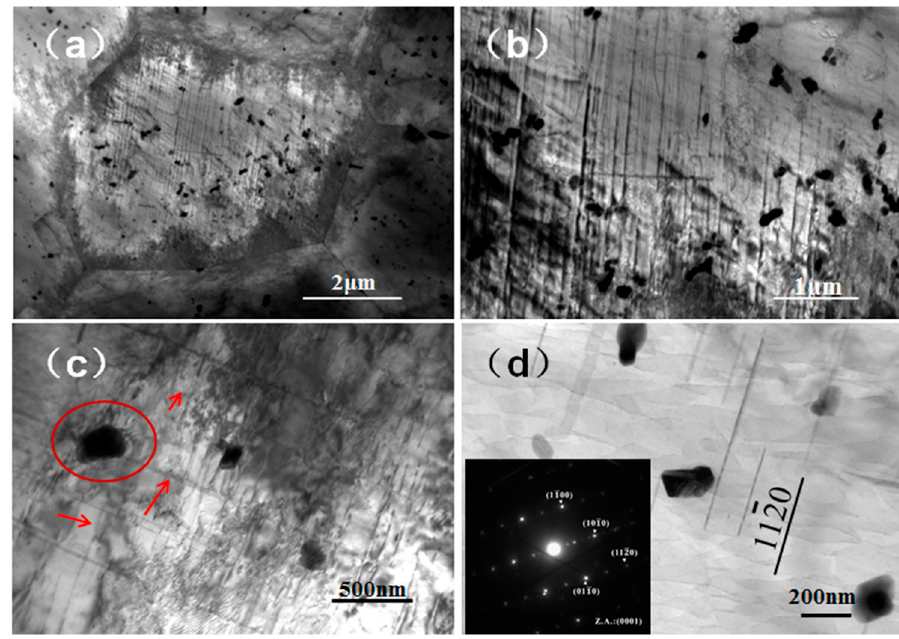
Figure 7. TEM analysis of Mg-6Zn-0.5Nd-0.8Ca alloy extruded at medium temperature. ( a ) is a bright field phase of the grain. ( b ) is an enlarged view of ( a ). ( c ) is a bright-field micrograph of the dislocation and the precipitated phase. ( d ) is the precipitated phases of small particles and selected area electron diffraction